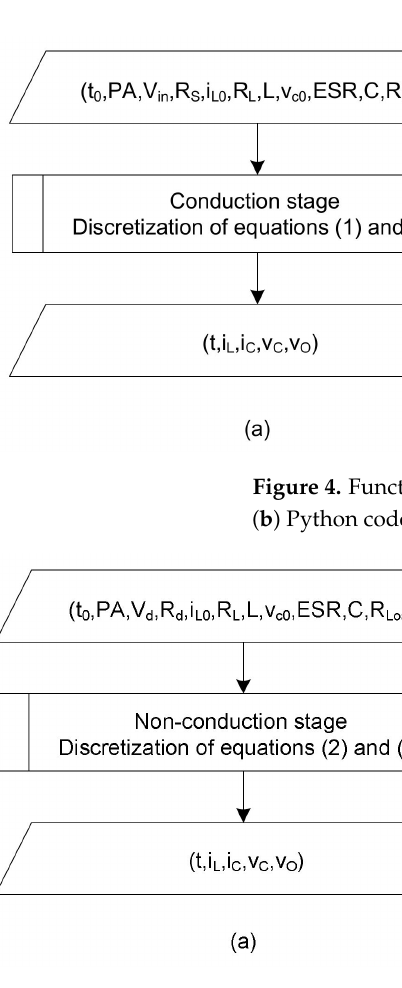
Figure 5. Function that models the behavior of the converter during the off state: ( a ) Algorithm and ( b ) Python